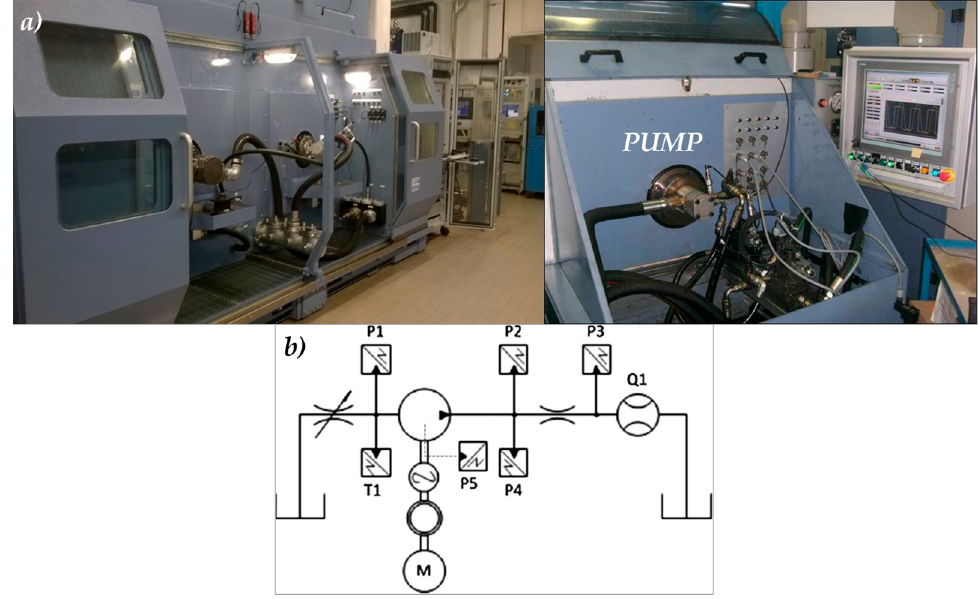
Figure 10. ( a ) Test bench of Casappa S.p.A., ( b ) test bench layout.